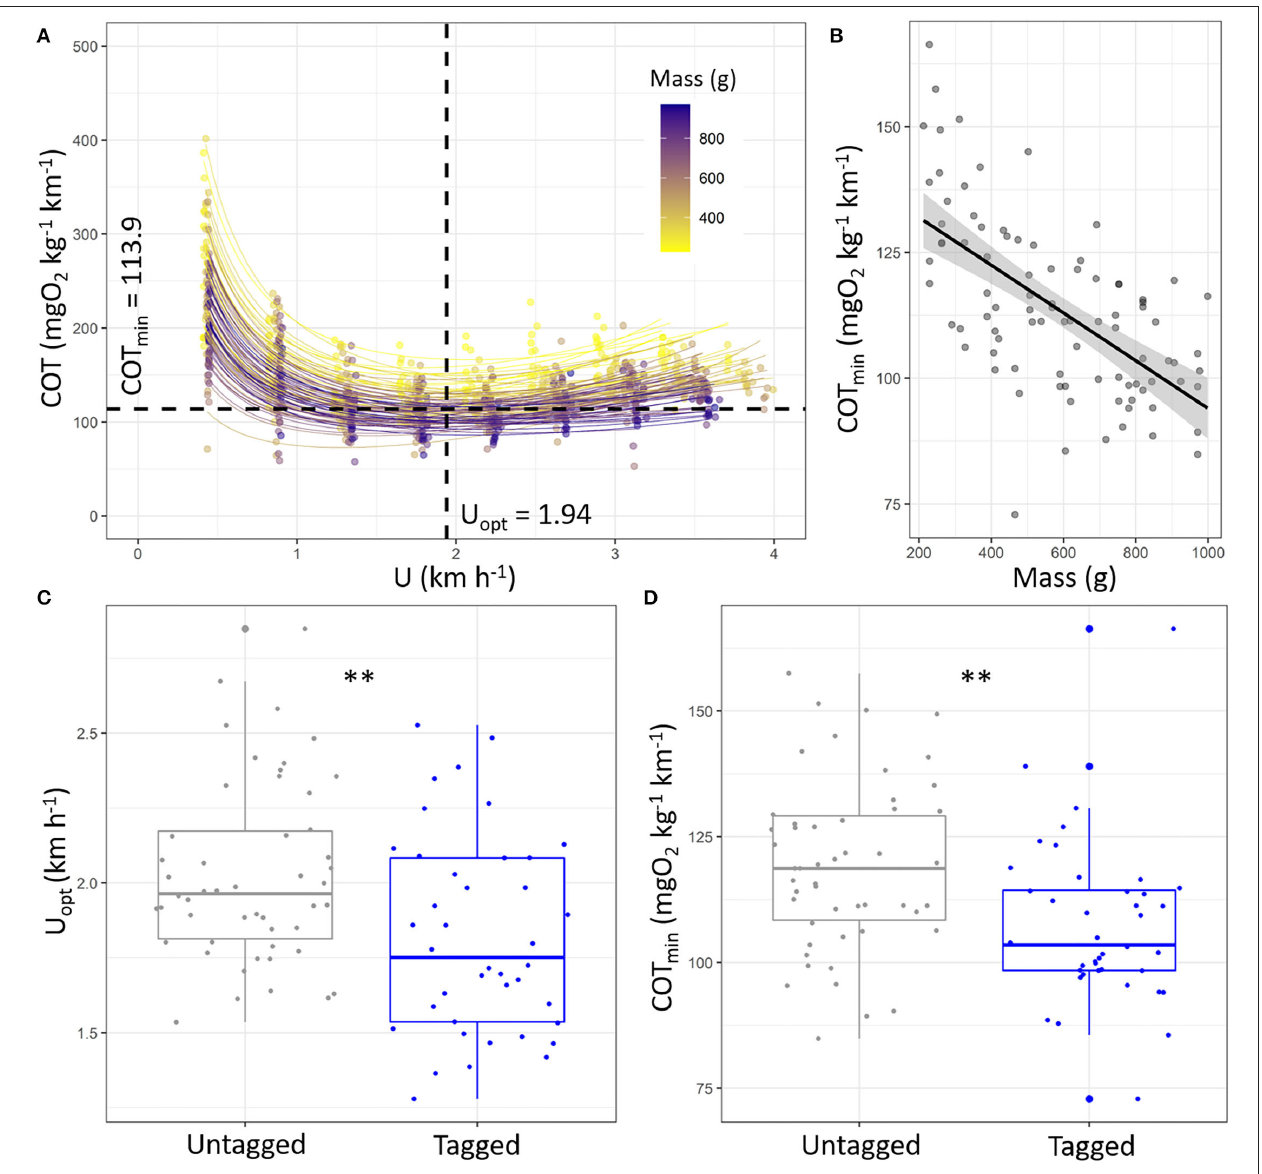
FIGURE 4 | (A) Cost of transport (COT, mgO 2 kg − 1 km − 1 ) as a function of speed (km h − 1 ) during the U crit trial of European sea bass ( Dicentrarchus labrax ; n = 90) and associated fits for each fish (refer to Supplementary Table S4 for details). Average values of U opt and COT min were added to the figure. (B) Estimated COT min (mgO 2 kg − 1 km − 1 ) as function of fish mass (g). The line represents linear regression, and the shape around represents the 95% confidence interval of the linear regression ( p < 0.05). Boxplot of the (C) U opt (km h − 1 ) and (D) COT min (mgO 2 kg − 1 km − 1 ) for untagged fish ( n = 50, gray) and tagged fish ( n = 40, blue). The significant differences are indicated for U opt and COT min and depending on tagging condition ( t -test: **: p <